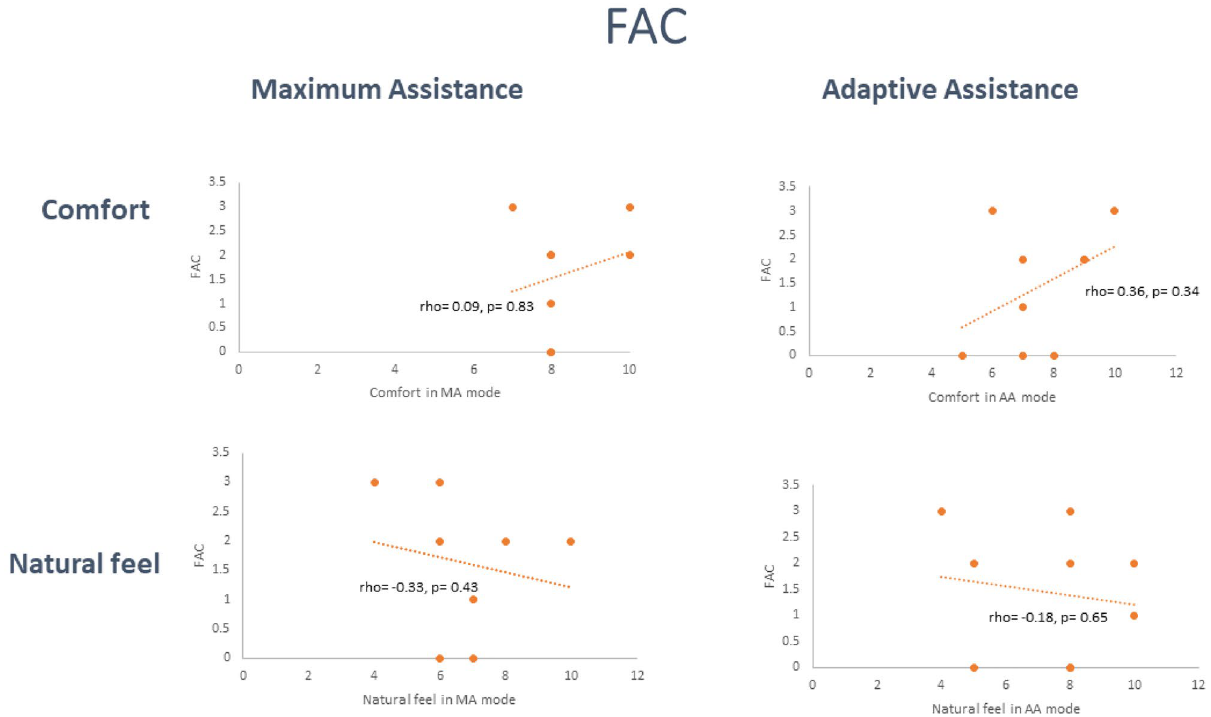
Figure 1. Correlation between FAC and Likert rating scales.